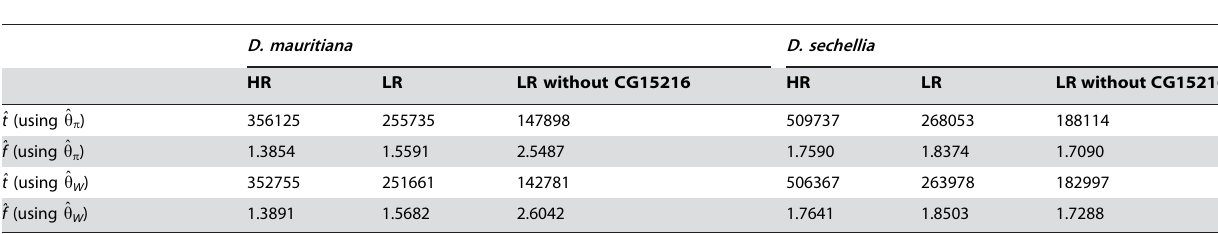
Table 4. Estimates of t and f using the 2-parameter